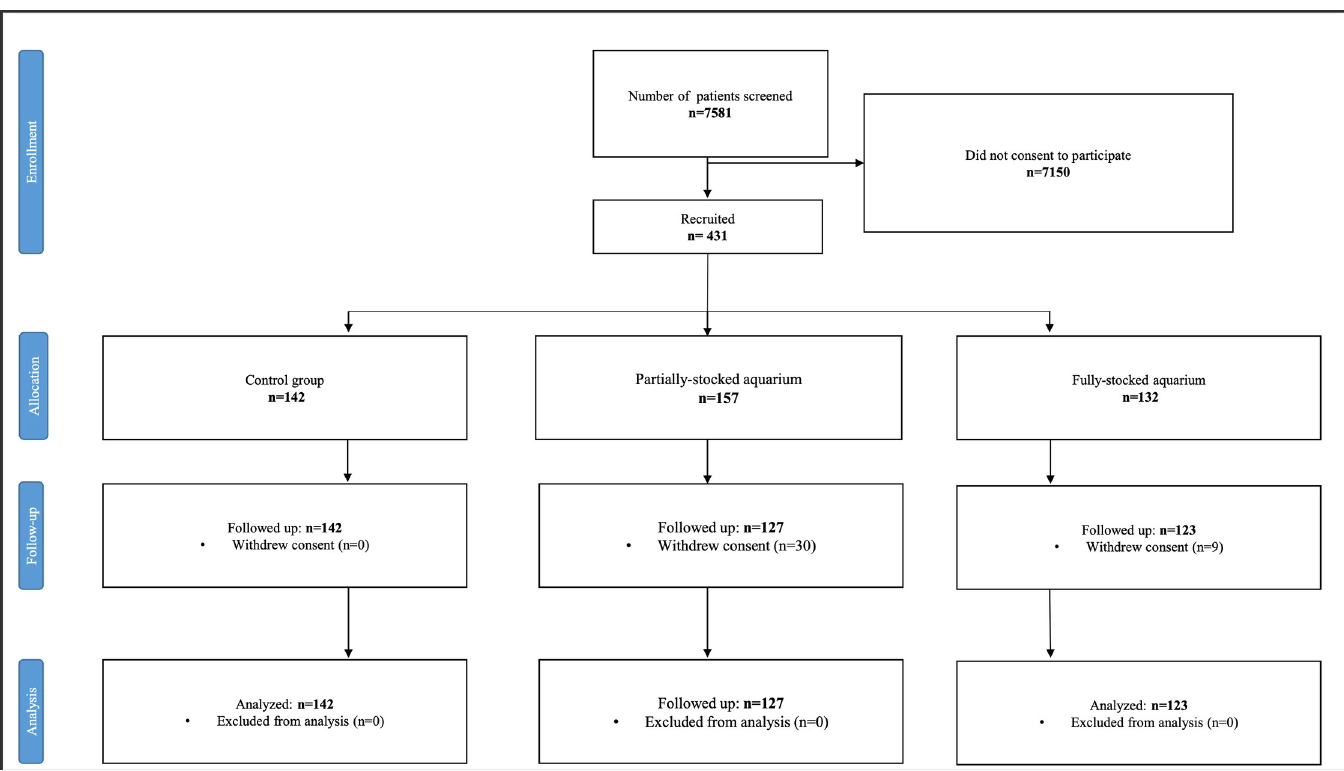
Fig 5. CONSORT flow diagram showing the patients’ enrolment, allocation, follow-up and analysis process. n- number; Control group- waiting area without aquarium; Intervention group #1- Waiting area with a partially-equipped aquarium; Intervention group #3- Waiting area with a fully-equipped aquarium.